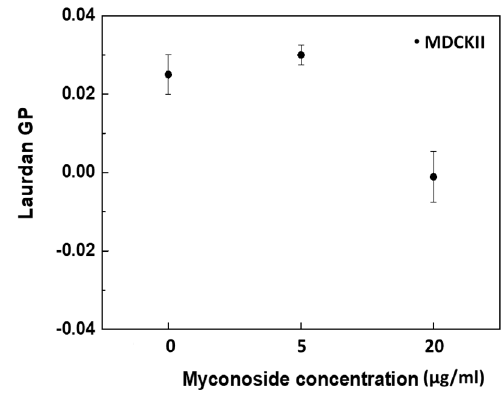
Figure 5. Fluorescence spectroscopy study of plasma membrane lipid order of untreated and treated with myconoside MDCKII cells. Laurdan GP values as a function of myconoside concentration. Error bars correspond to SDs (n = 3). GP values of all treated with myconoside MDCKII cells are significantly different from the untreated ones at p < 0.05.